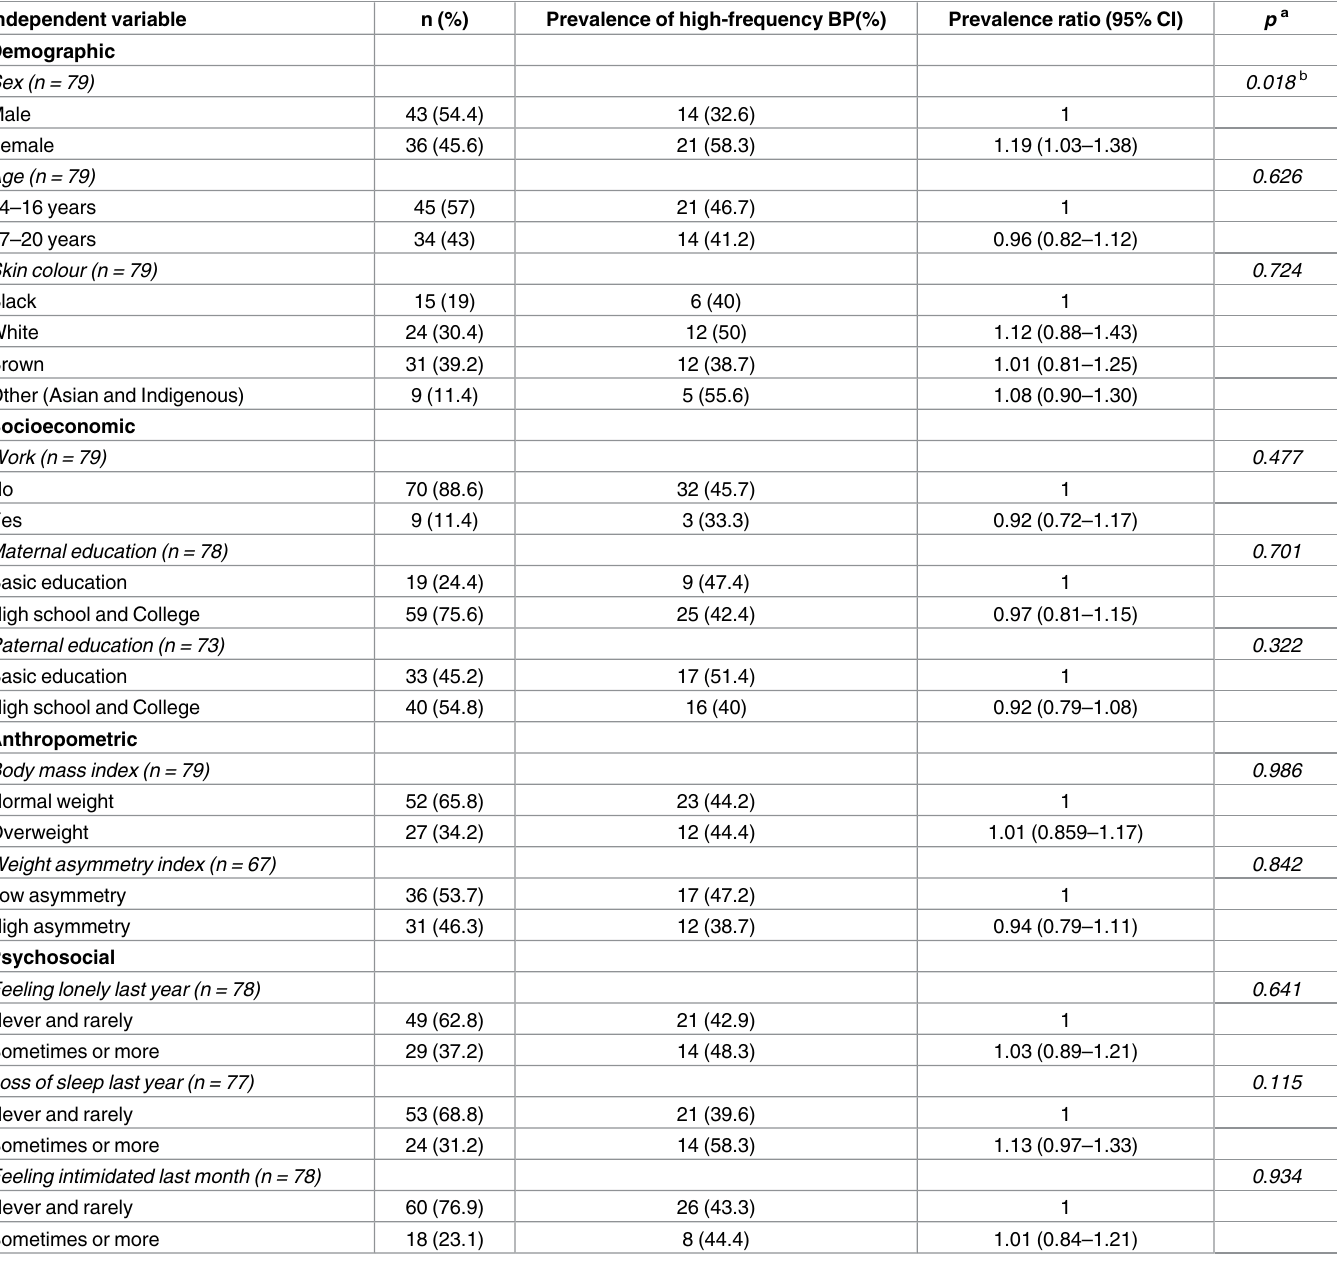
Table 4. Association ( χ 2 ) and prevalence ratio of back pain frequency with independent variables (demographic, socioeconomic, anthropometric, and psychosocial). Independent